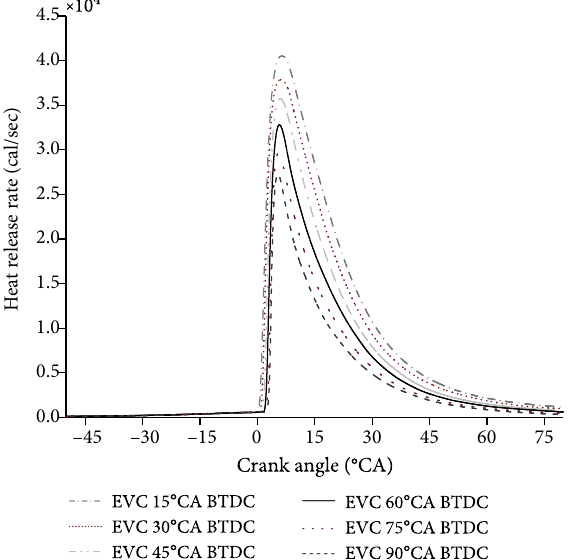
Figure 8: In fl uence of advanced EVC on temperature.